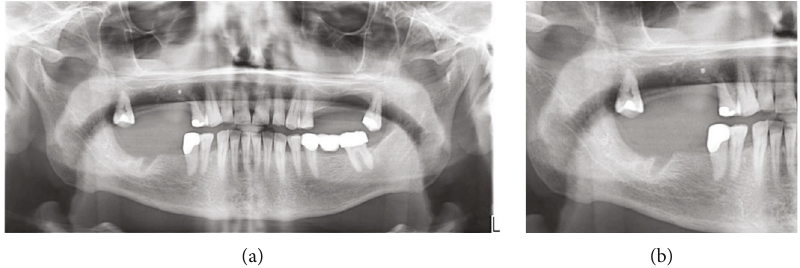
Figure 11: (a, b) Final OPG X-ray (17/06/2021): no relevant fi ndings on the extraction sites (magni fi cation